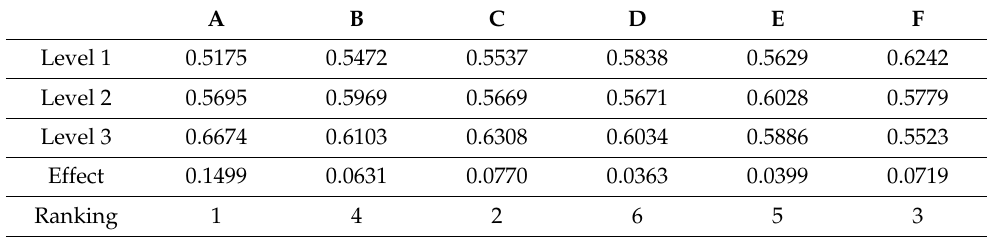
Table 24. Response table of the grey relational grade.